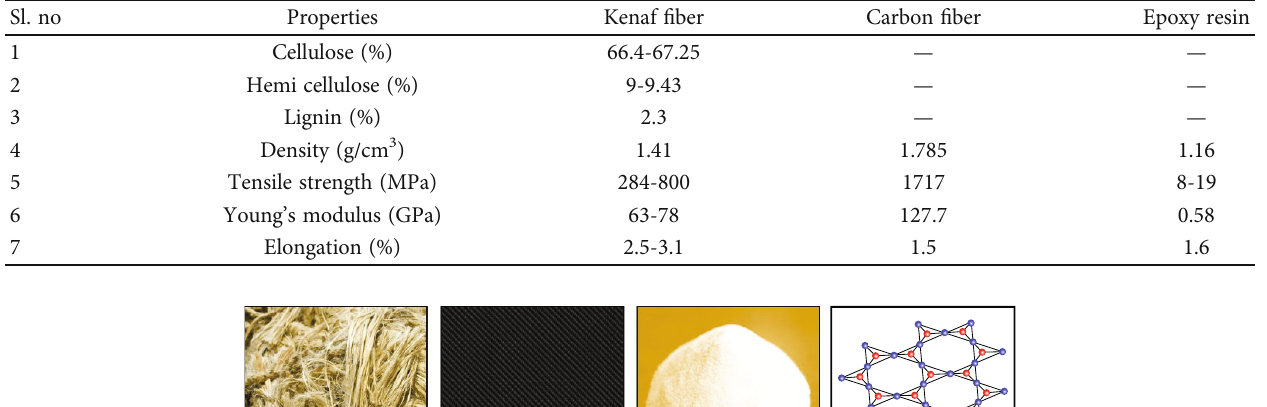
Table 1: Mechanical properties of reinforcements and matrix.